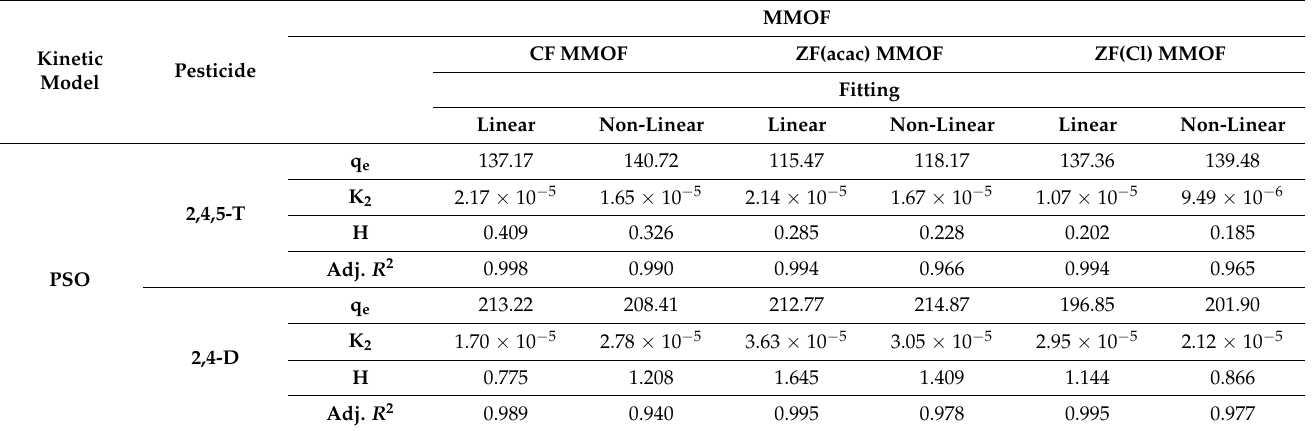
Table 3. Kinetic data for all three MMOFs, both tested pesticides, fitted to PSO model, both linearly and non-linearly.